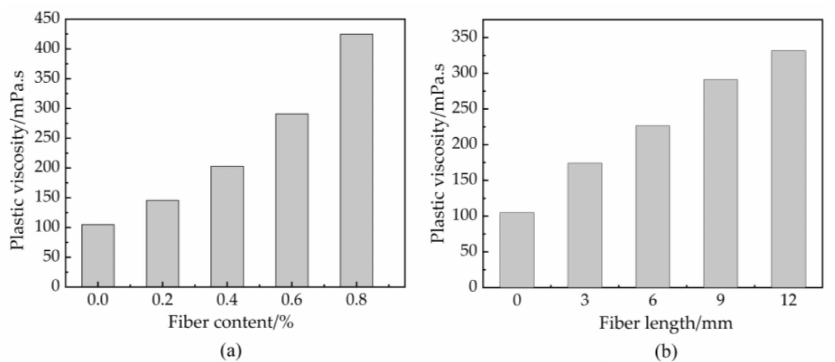
Figure 7. Effect of basalt fiber on plastic viscosity of BFBCP: ( a ) fiber content, ( b ) fiber